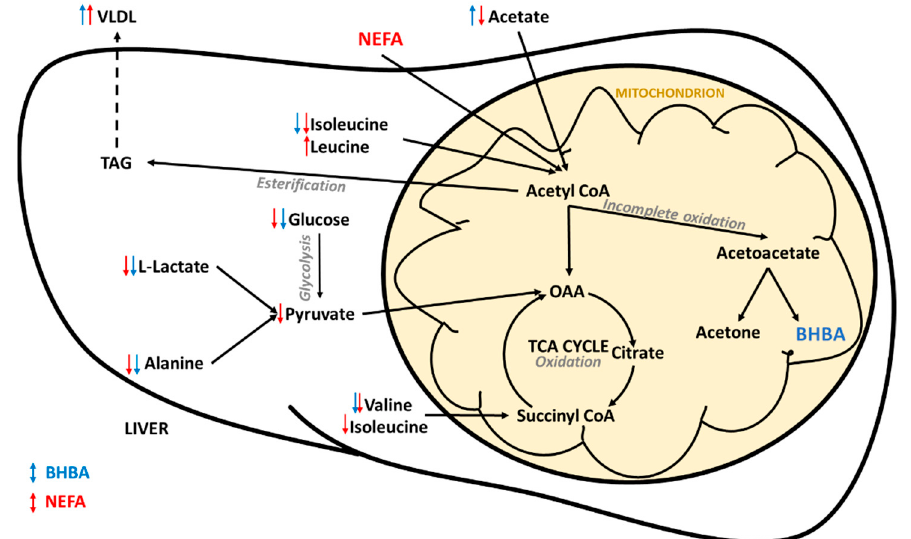
Figure 5. Summary of hepatic energy metabolism in early lactation dairy cows. Arrows indicate the direction of the relationship between the metabolites and the reference BHBA (blue) and non-esterified fatty acid (NEFA) (red) concentrations. BHBA = β -hydroxybutyrate; OAA = oxaloacetate; TAG = triglyceride, TCA = tricarboxylic acid, VLDL = very low density